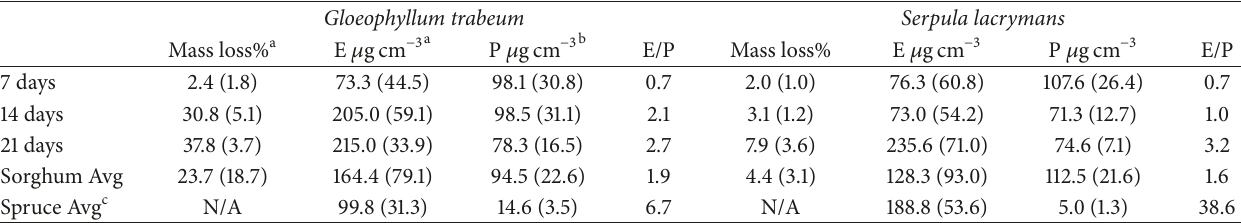
Table 1: Ergosterol (E), protein (P), and ergosterol/protein ratios (E/P) for sorghum sections degraded by Gloeophyllum trabeum and Serpula lacrymans for 7, 14, and 21 days. Protein and ergosterol levels are standardized to cm 3 of biomass.